Question: Give a one-sentence summary of this figure.
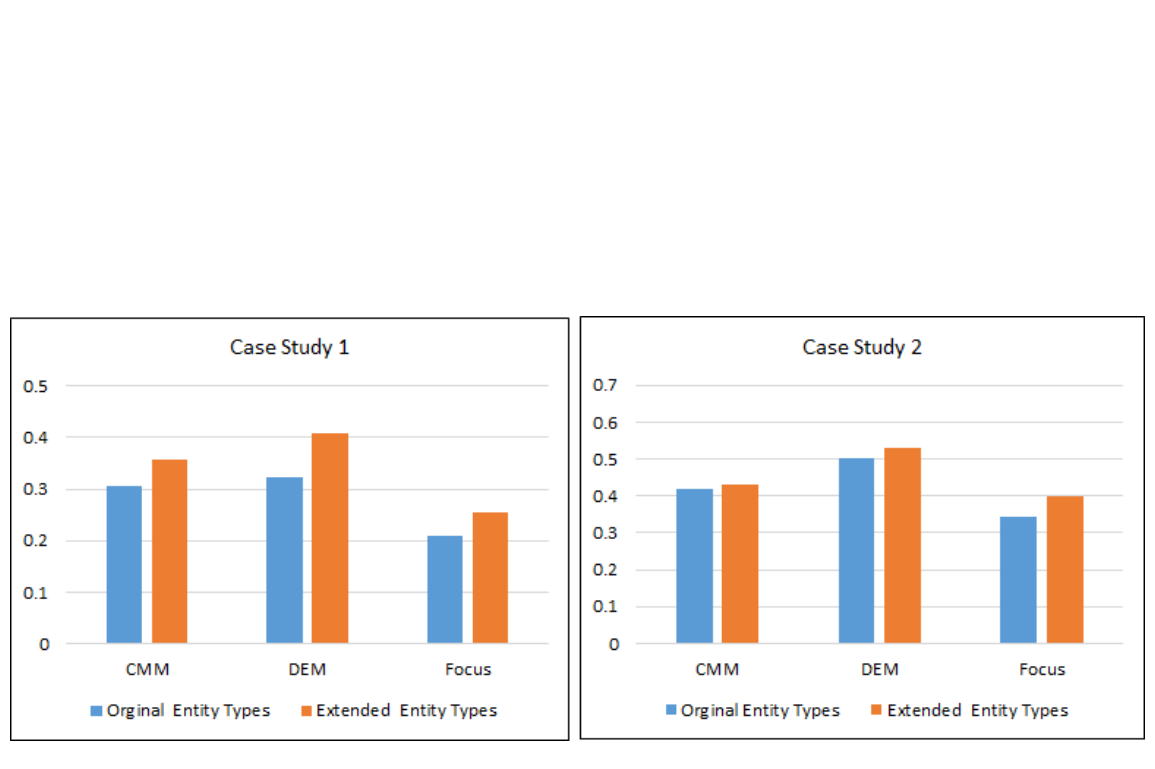
Answer: 6: Comparison of the entity types before and after the knowledge graph extension via assess- ment metrics.